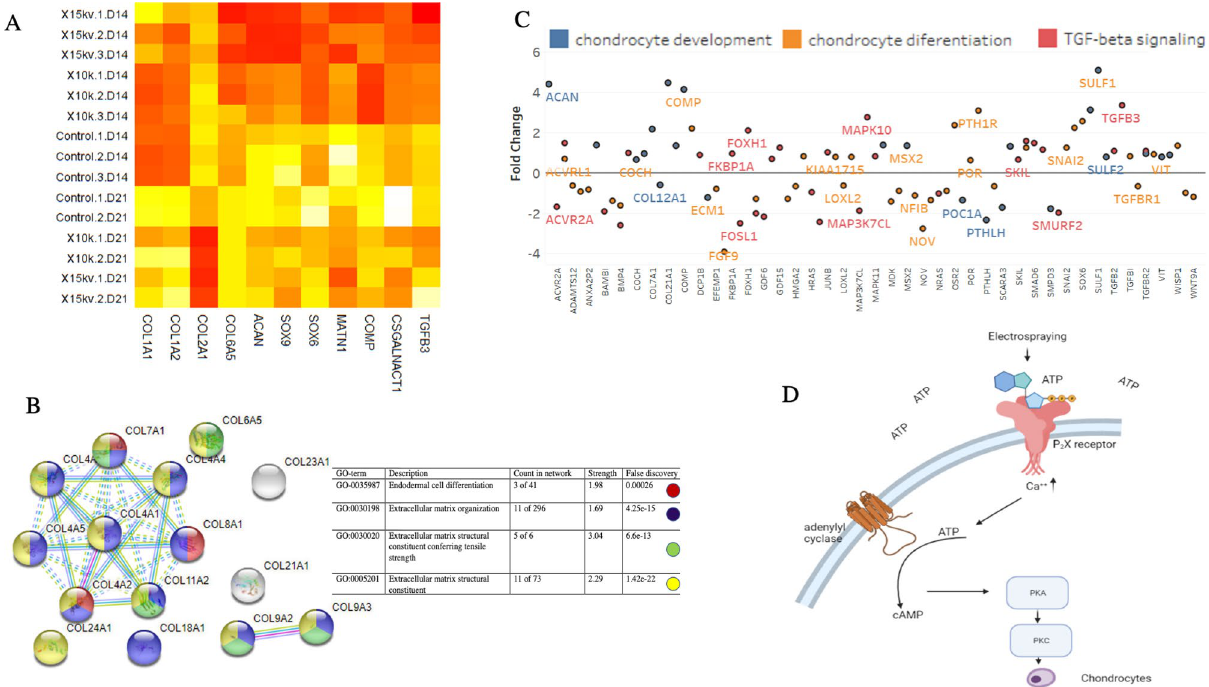
Figure 5. ( A ) Heat map of chondrogenesis related genes in control, 10 and 15 kV sample at D14 and D21 (N = 4). ( B ) Upregulated collagen genes network. ( C ) Enrichment analysis comparing electrosprayed and control samples. Y axis shows fold change. ( D ) Schematic of cell response to